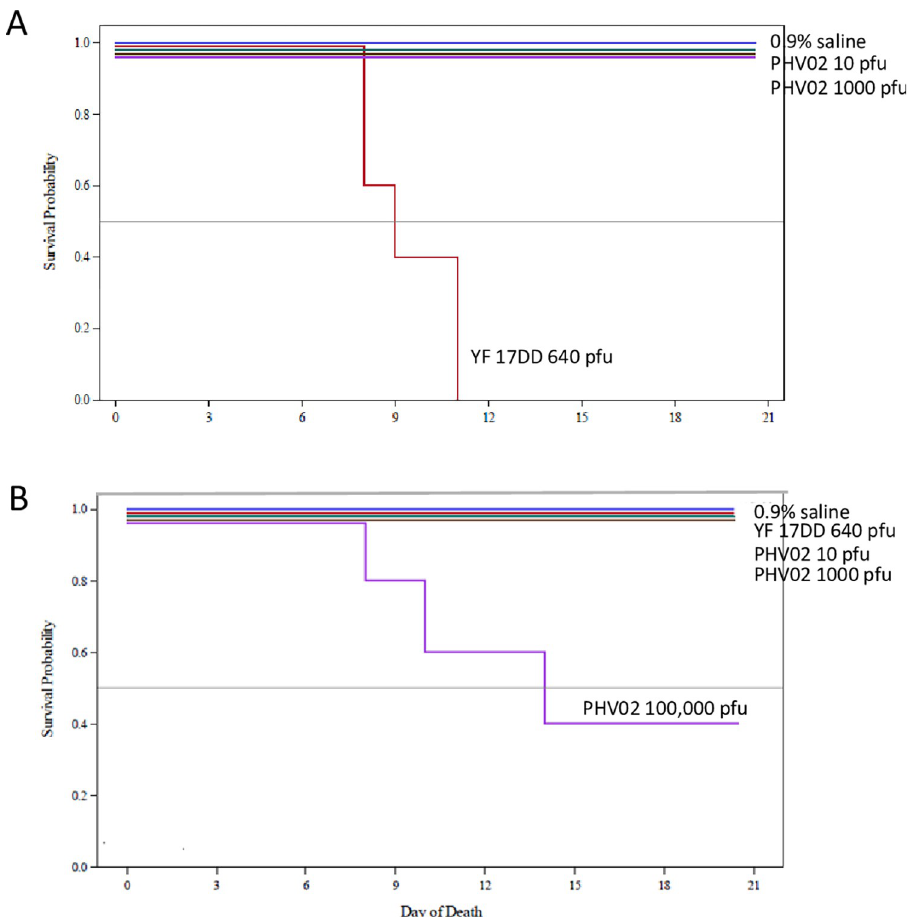
Fig 3. Survival distribution, 6- to 8-week-old ICR mice and Golden hamsters inoculated by the IC route. 6- to 8-week-old ICR mice Twenty μ L of PHV02 at graded doses or YF 17DD were inoculated IC into groups of 5 mice. The doses injected in 20 μ L were 100,000, 1000, or 10 pfu for PHV02 groups and 640 pfu for YF 17DD. 6- to 8-week- old Golden hamsters. Twenty μ L of PHV02 or YF 17DD were inoculated IC into groups of 5 hamsters. The doses injected in 20 μ L were 100,000, 1000, or 10 pfu for PHV02 groups and 640 pfu for YF 17DD. Animals were observed for 21 consecutive days and clinical signs and deaths recorded. Hamsters inoculated with 100,000 pfu of PHV02 virus had a 60% mortality ratio for an IC LD50 of 46,800 pfu. In contrast to adult mice which are susceptible to lethal IC infection with YF 17DD Fig 3A ), adult hamsters showed no illness or deaths. Pilot neurovirulence test in mice and hamsters of PHV02 vs. YF 17DD vaccine Graded doses of PHV02 [10, 1000, 100,000 plaque forming units (pfu)] or 640 pfu of YF 17DD were inoculated by the IC route into ICR mice and Golden hamsters 2 days, 8 days or 6-8 weeks of age. The dose of YF 17DD employed was the highest dose possible (reconstituted lyophilized commercial vaccine without further dilution) and approximated the intermediate dose of the PHV02 test article. Negative controls were inoculated with 0.9% saline. PHV02 and YF 17DD reference control (but not 0.9% saline) were lethal for 2 and 8-day old mice, and therefore results for more susceptible 2-day old animals are not presented. In 8-day old mice inoculated IC, PHV02 was 100% lethal at the 100,000 and 1000 pfu dose levels and 85% at the 10 pfu dose level ( Fig 2A ). The dose response for mortality was close to, but not statistically significant (p=0.0666, Cochran-Armitage test). However, the survival